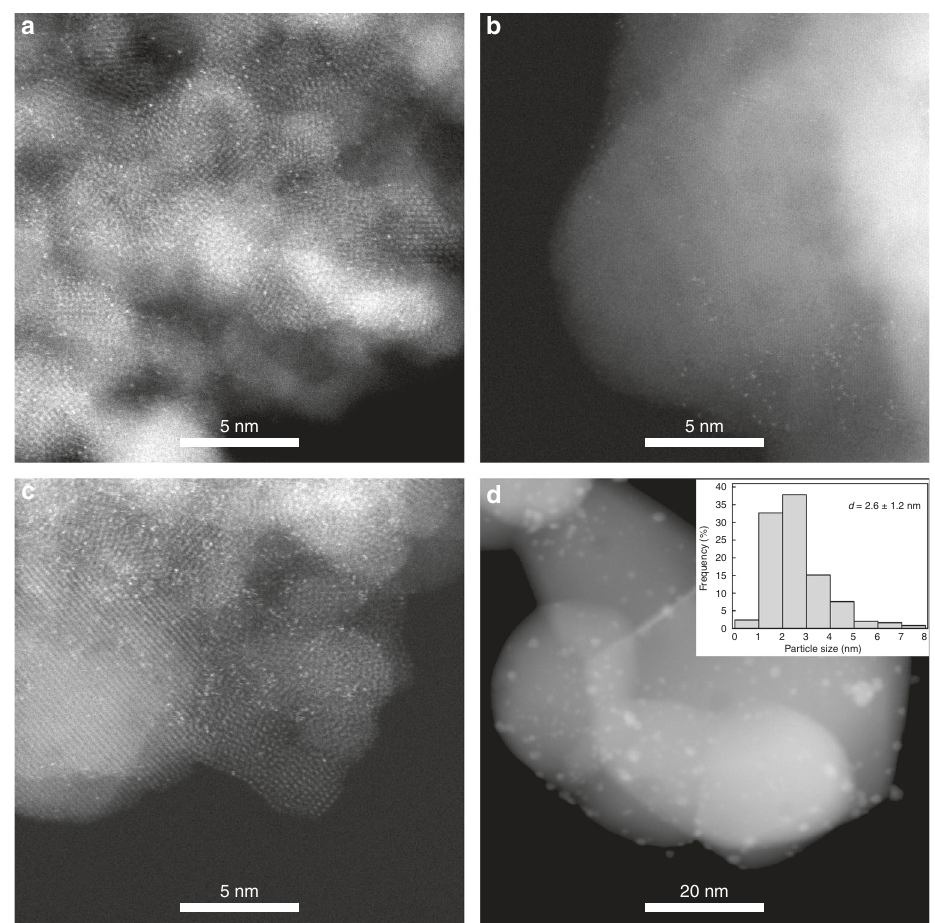
Fig. 2 HAADF-STEM images of Pt 1 /Fe 2 O 3 -T SACs and Pt/Fe 2 O 3 NP catalyst. A large number of single atoms of Pt (bright dots) are clearly observed in Pt 1 / Fe 2 O 3 -500 a , Pt 1 /Fe 2 O 3 -550 b , and Pt 1 /Fe 2 O 3 -600 c catalysts, while non-uniform NPs are observed in Pt/Fe 2 O 3 -600-10 min d NP catalyst (the inset is the histogram of the Pt particle size